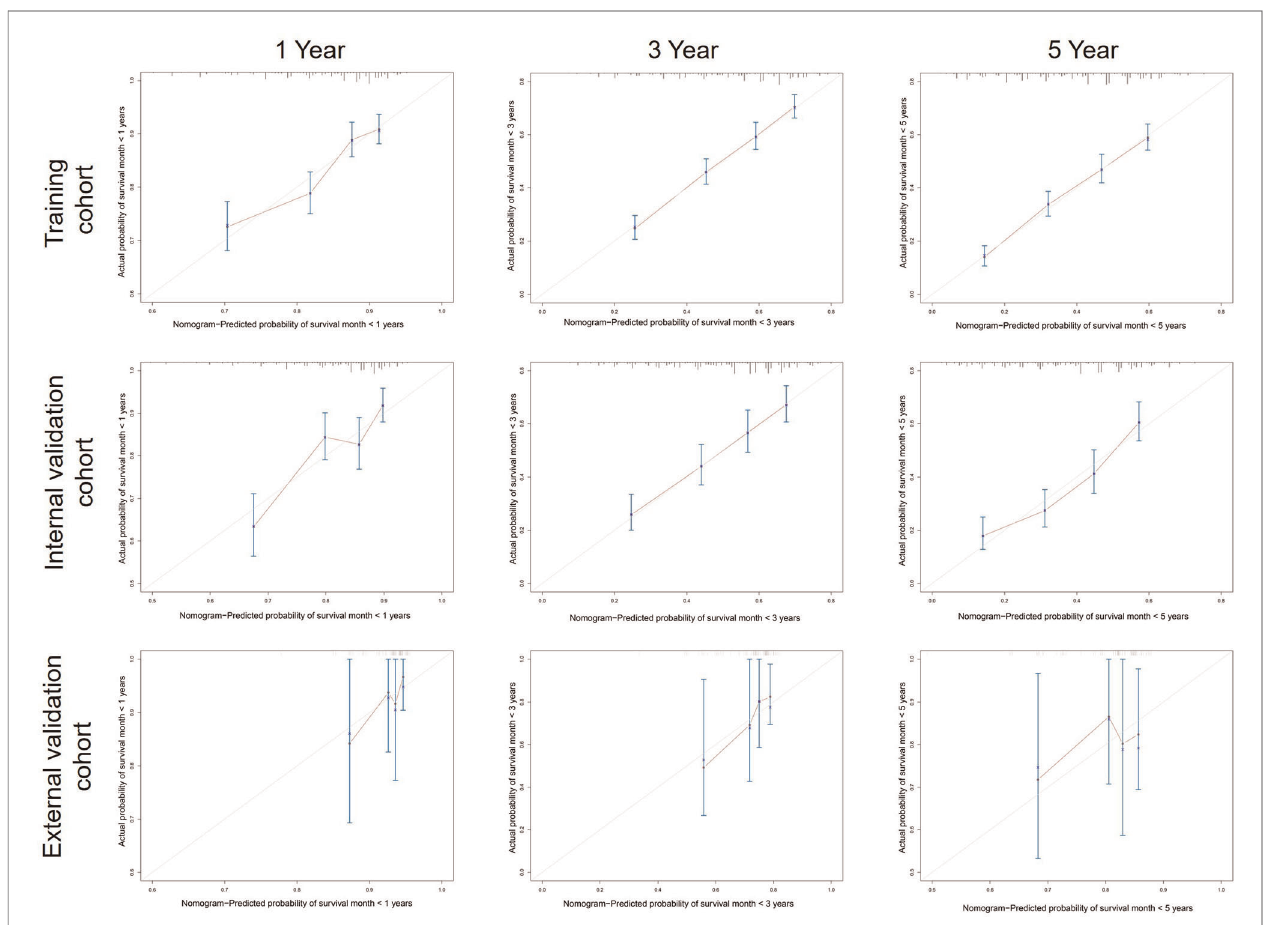
FIGURE 3 | Calibration curves predicting patients ’ 1-, 3-, and 5-year OS in the training, internal, and external cohorts.